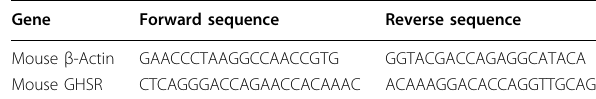
Table 1 Primers used to determine GHSR expression in the VTA and the Edinger – Westphal